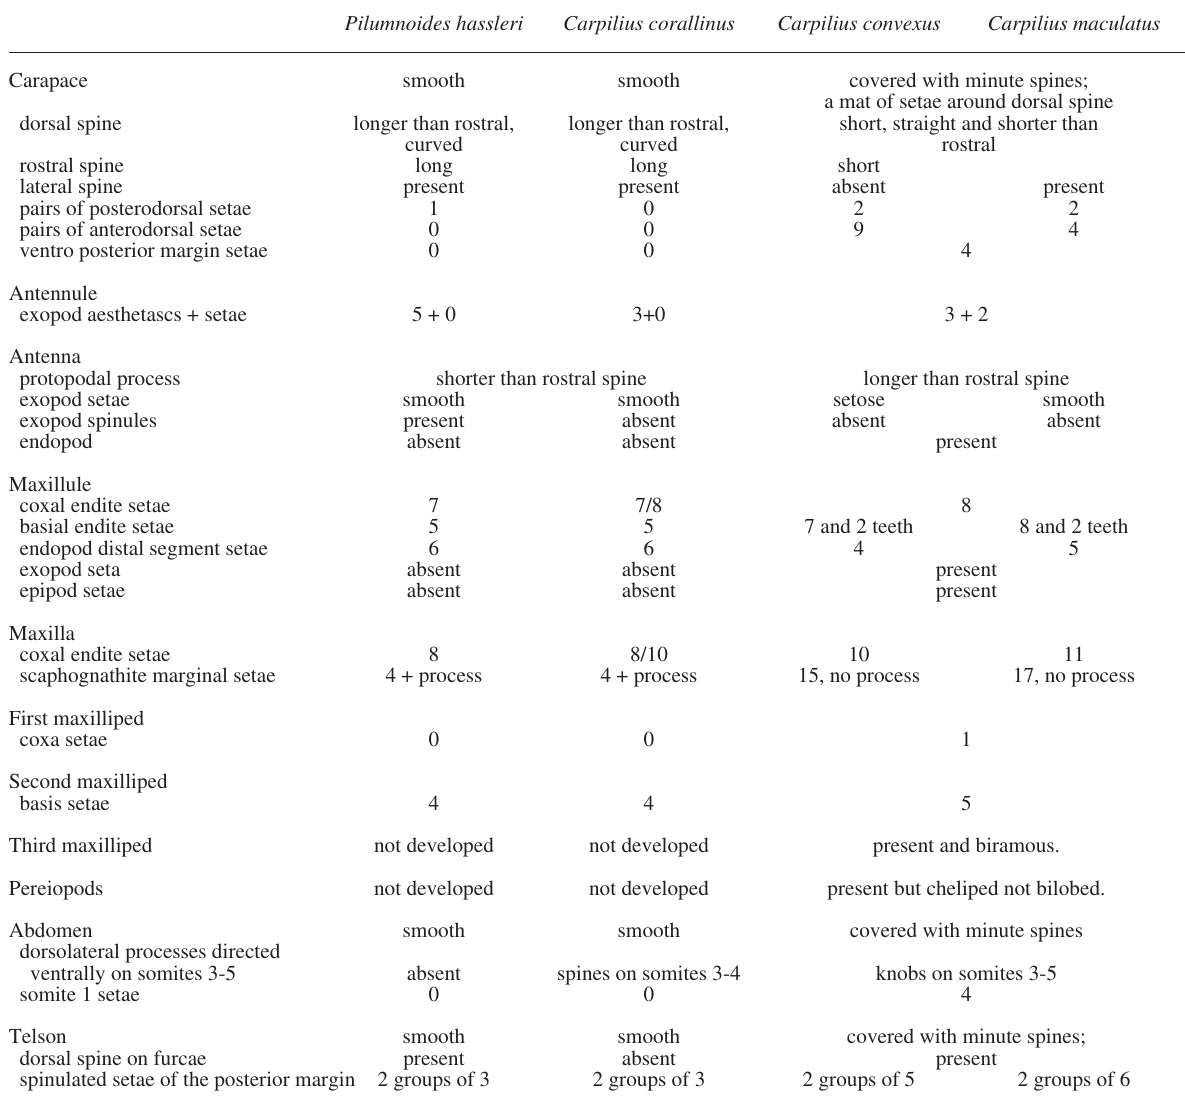
Table 4. – difference between the morphology of zoeas i of Pilumnoides hassleri and Carpilius corallinus (herbst, 1783) by Laughglin et al . (1983), C. convexus (Forskål, 1775) and C. maculatus (Linnaeus, 1758) by Clark et al .